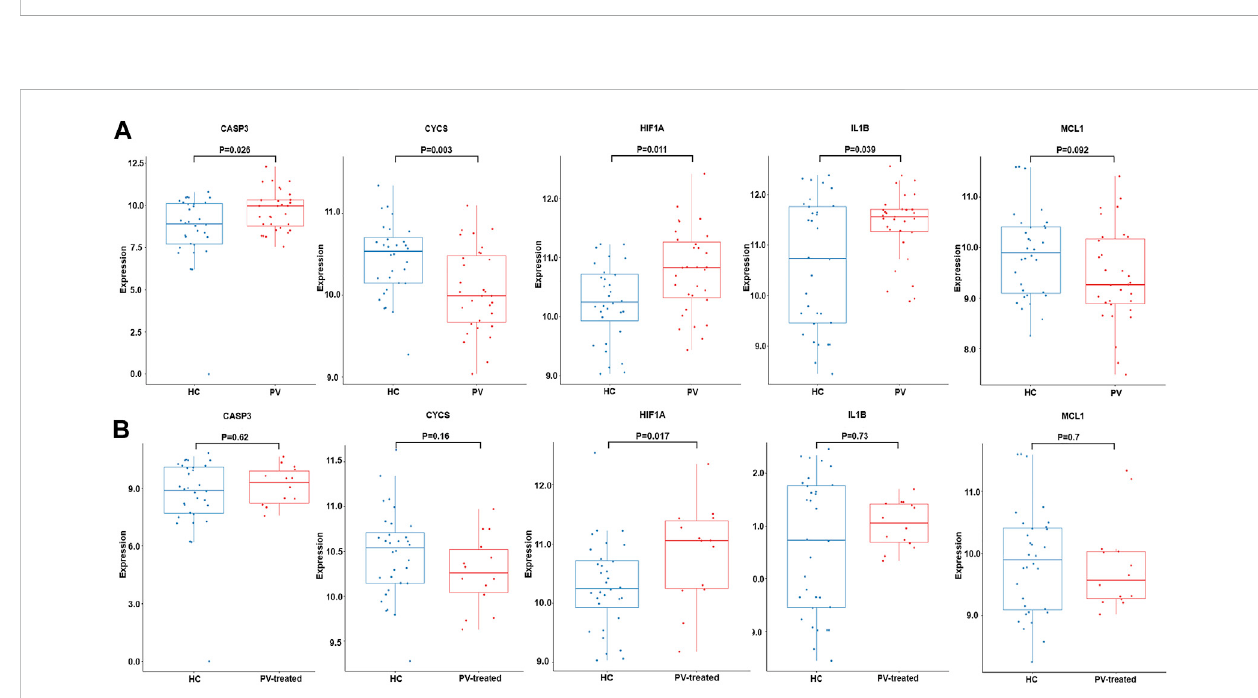
FIGURE 7 Expression of CASP3, CYCS, HIF1A, IL1B and MCL1. The expression difference of CASP3, CYCS, HIF1A, IL1B and MCL1 in GSE145802 validation set in untreated-PV patients (PV) and healthy controls (HC) (A) , and treated-PV patients (PV-treated) and HC (B)